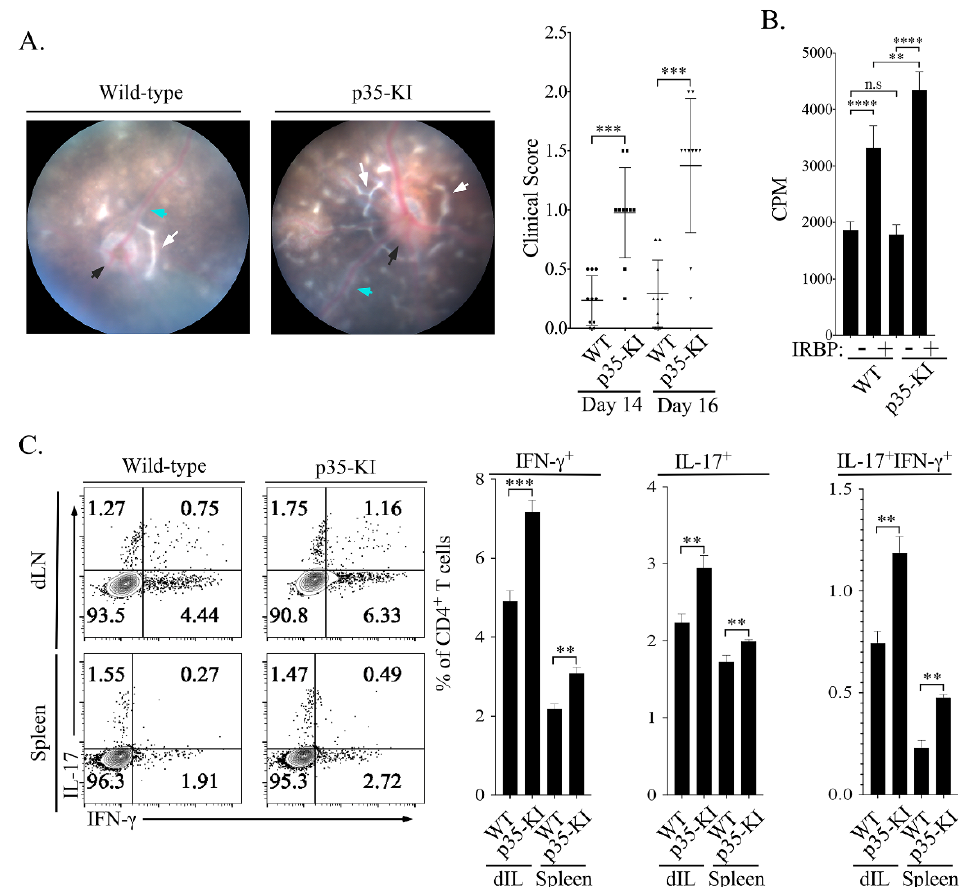
Figure 4. p35-KI mice develop severe experimental autoimmune uveitis (EAU). ( A ) EAU was induced in WT C57BL/6J or p35-KI mice by immunization with IRBP 651-670 peptide in CFA ( n = 12), and disease progression was analyzed by fundoscopy. Black arrow indicates inflammation with blurred optic disc margins and enlarged juxtapupillary areas; blue arrows indicate retinal vasculitis; white arrows indicate yellow-whitish retinal and choroidal infiltrates. Clinical scores and assessment of disease severity were based on changes at the optic nerve disc or retinal vessels and retinal and choroidal infiltrates. ( B ) Draining LN cells (dLN) isolated from C57BL/6J or p35-KI mice with EAU, stimulated in vitro in the absence or presence of IRBP 651-670 , and proliferation of the cells was assessed by the [ 3 H]-thymidine incorporation assay as described in Methods section. Data are presented as mean values of CPM of five replicate cultures. ( C ) dLN and spleen cells from C57BL/6J or p35-KI EAU mice and analyzed by the intracellular cytokine expression assay. Numbers in quadrants indicate percentage of CD4 + T cells expressing IFN- γ and/or IL-17. Results represent 3 independent studies. ** p < 0.01; *** p < 0.001; **** p <